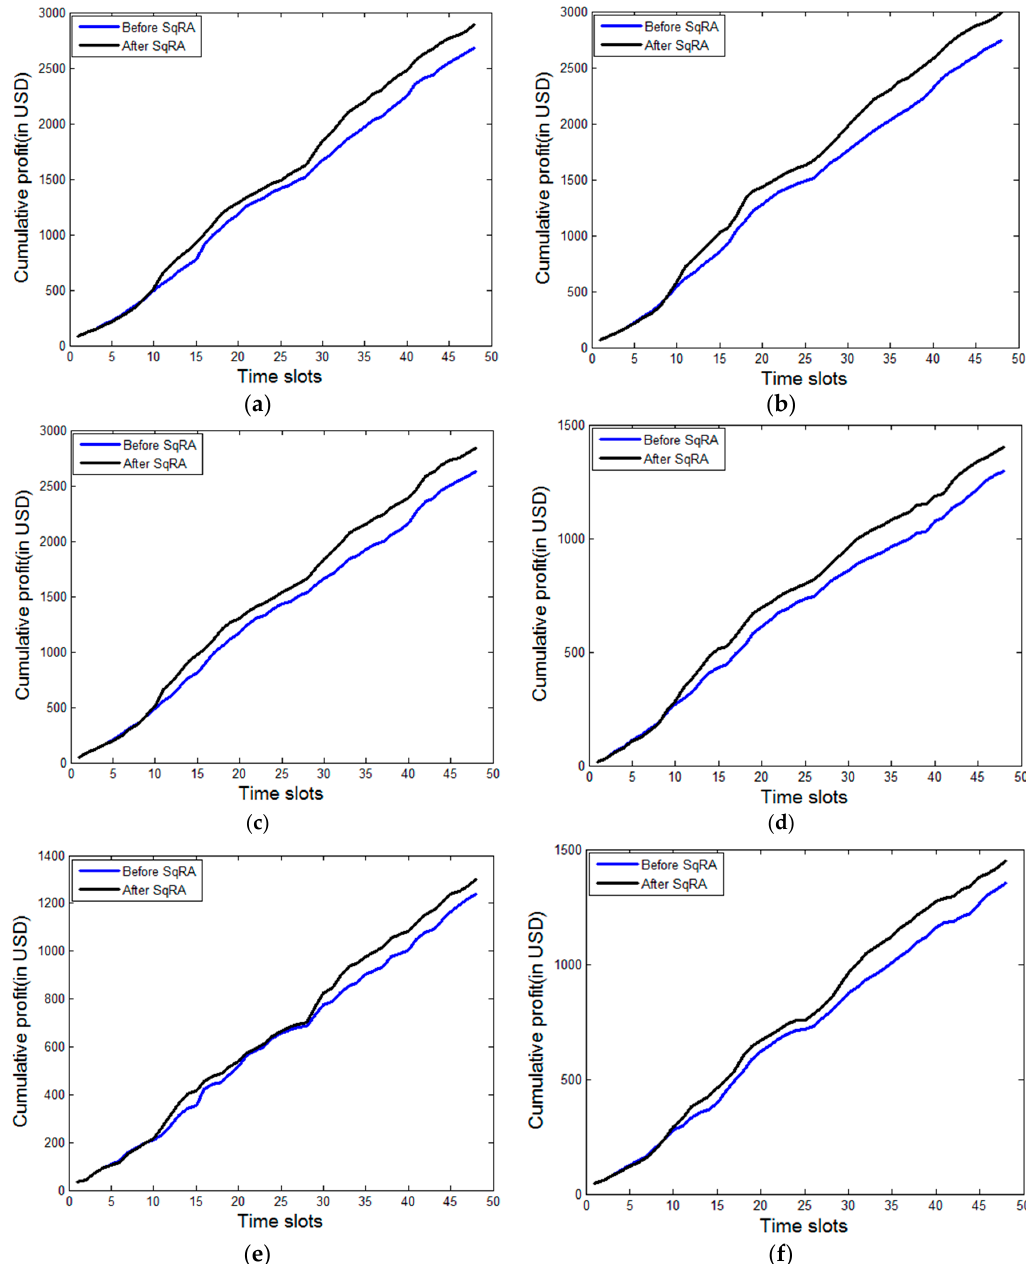
Figure 8. Profit earned by the IaaS providers over time before and after implementation of SqRA: ( a ) IaaS provider-1; ( b ) IaaS provider-2; and ( c ) IaaS provider-3.